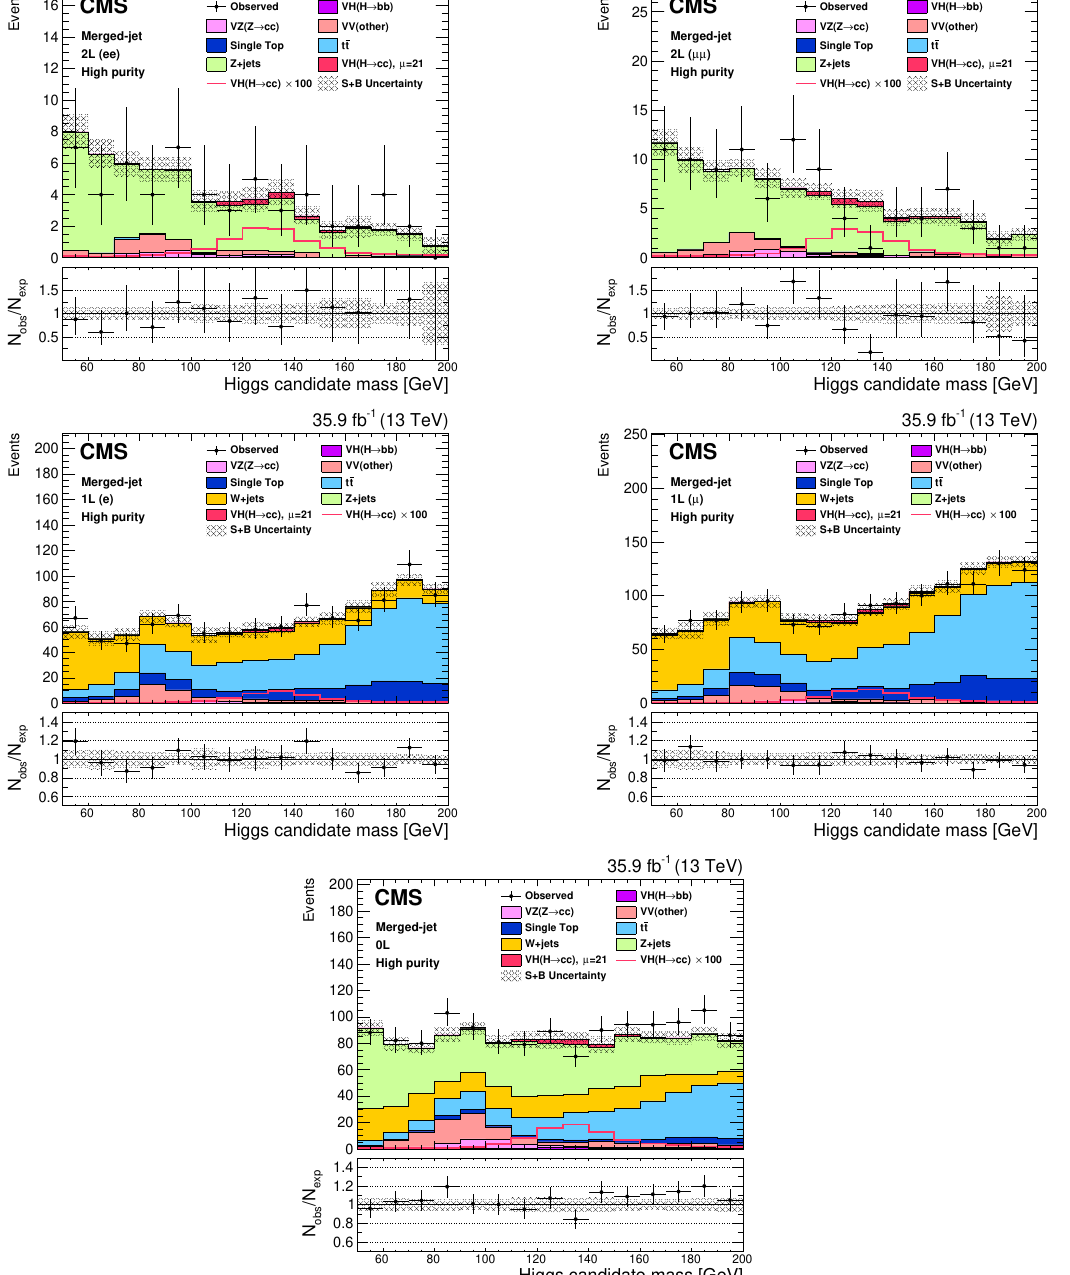
Figure 6 . The m distribution of H in data and simulation in the merged-jet topology analysis SD signal regions after the maximum likelihood (cid:12)t, for events in the high purity category. Upper row: 2L channel, electrons (left) and muons (right); middle row: 1L channel, electron (left) and muon (right); lower row: 0L channel. The plain red histograms represent the signal contribution normalized by the post-(cid:12)t value of (cid:22) , while the red line histograms show the expected VH(H ! cc) signal contribution multiplied by a factor 100.